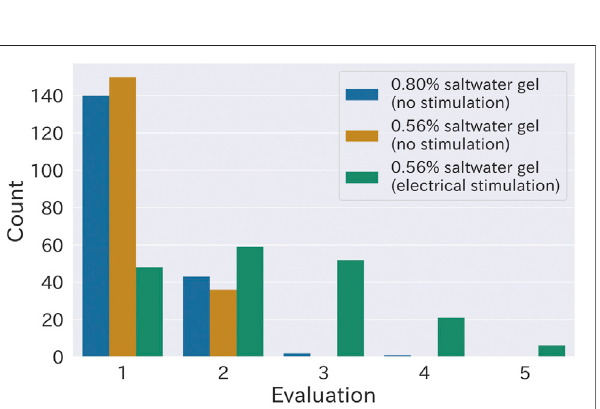
FIGURE 12 | Evaluation results of discomfort for each condition in the experiment 2. The numerical values indicate 1: none, 2: low (not bothersome), 3: mild (bothersome in daily life, but not unbearable), 4: moderate (bearable in testing, but unbearable in daily life), and 5: severe (unbearable).